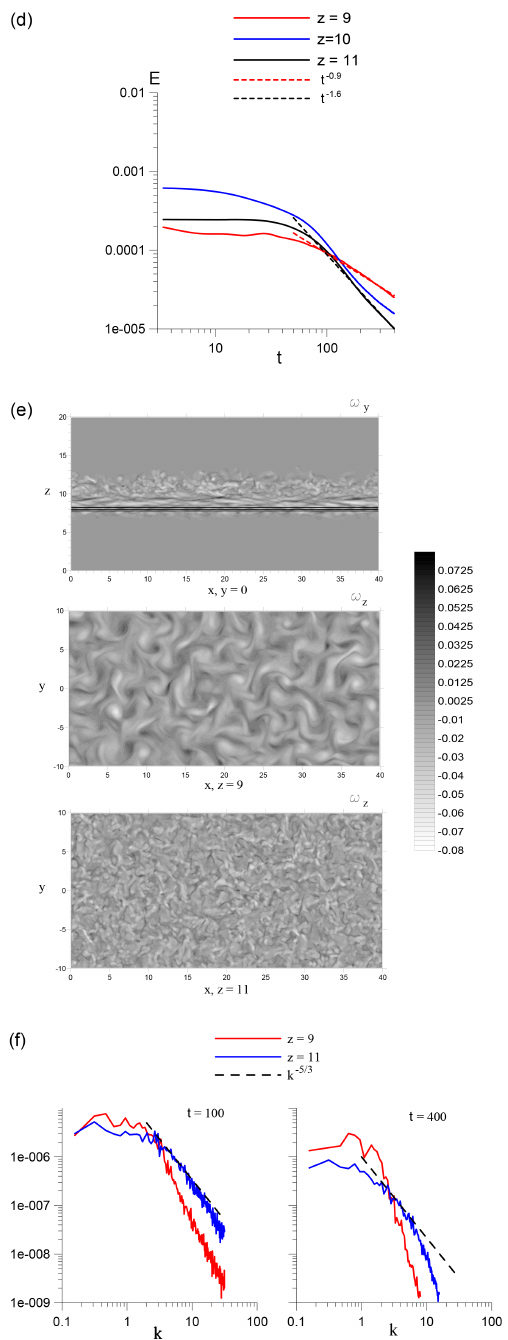
Figure 3. (d) Temporal development of the fluid kinetic energy, E , at different z levels ( z = 9, 10, 11) in DNS with no initially induced IW. (e) Instantaneous distribution of the vorticity y and z components ω y (top panel) and ω z (middle and bottom panels) (in grey scale) obtained in DNS in the vertical and horizontal planes at t = 400 with no initially excited IW. Density contours 1.3, 1.5 and 1.7 are also shown in the ( x , z ) plane (top panel). (f) Kinetic energy power spectrum obtained in DNS with no initially excited IWs at t = 100 (left) and t = 400 (right) at different z levels. Dashed line shows Kolmogorov’s k − 5 / 3